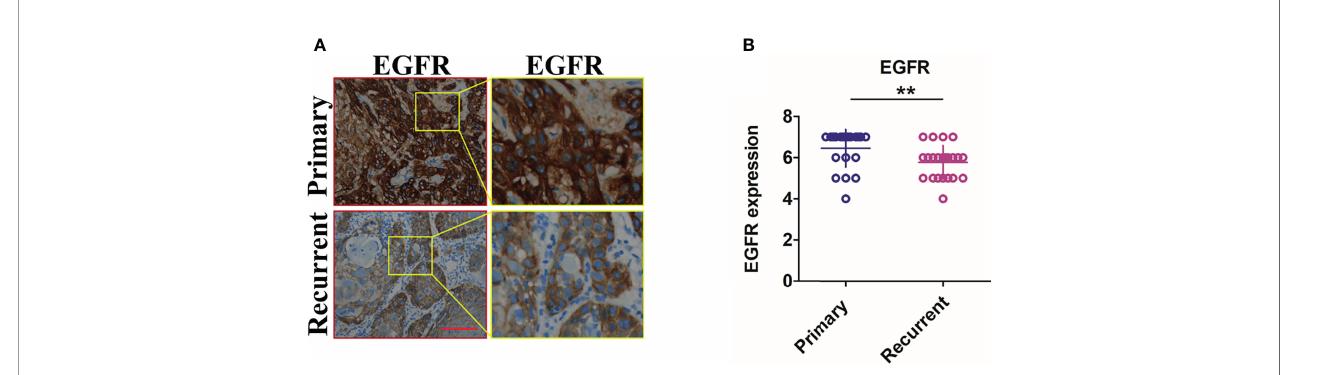
FIGURE 3 | Expression of EGFR in recurrent OSCC tissues of patients with normal blood glucose taking metformin. (A) typical pictures of EGFR staining in the primary and recurrent OSCC in the same patient. (B) Semi-quantitative analysis results in the primary and recurrent OSCC in the same patient. Scale bar, 200 m m, ** P